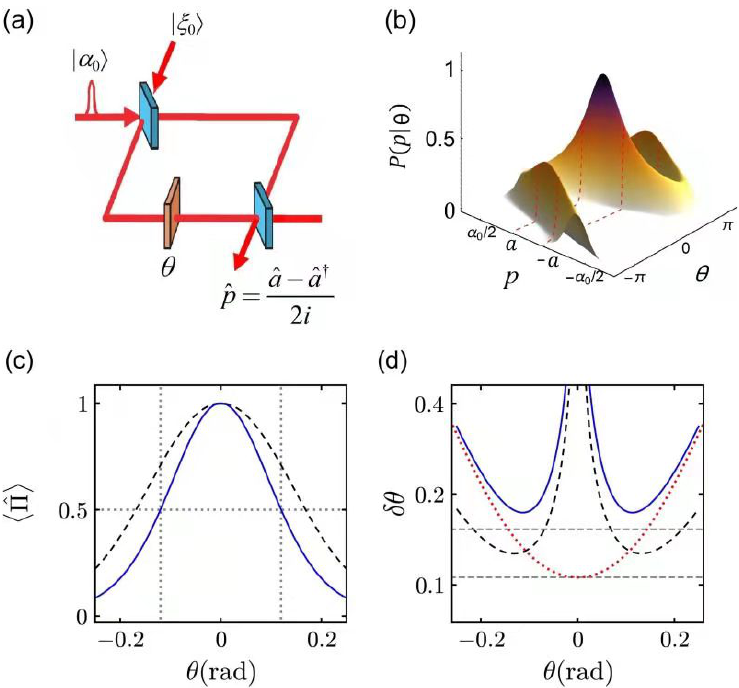
Figure 1. ( a ) Homodyne detection at one port of the interferometer fed by a coherent state | α 0 (cid:105) and a squeezed vacuum | ξ 0 (cid:105) , equivalent to the field quadrature measurement; ( b ) 3D plot of the measurement probability given by Equation (6); ( c , d ) the output signal and the phase sensitivity for a = 0.18 (solid) and a = 0.5 (dashed), obtained by taking µ ± = 0 and µ 0 = 1/erf ( Equations (12) or (14). The red dotted line in ( d ) is the CRB for the three-outcome measurement for a = 0.18. Vertical lines in ( c ) the FWHM of the signal. Horizontal lines in ( d ) the upper one √ ¯ n and the other is given by Equation (23). Other paraments: ¯ n a = α 2 corresponds to the SNL 1/ ¯ n b = sinh 2 r = 0.687 (i.e., e − r = 0.47), and (cid:36) = 0.58, similar to Ref.